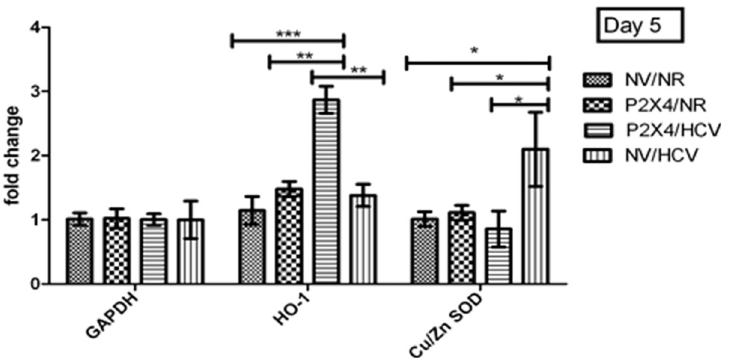
Fig 13. Expression of antioxidants on day 5 of post infection. All values are expressed as mean ± SEM, � P � 0.05 vs. control NV/HCV.